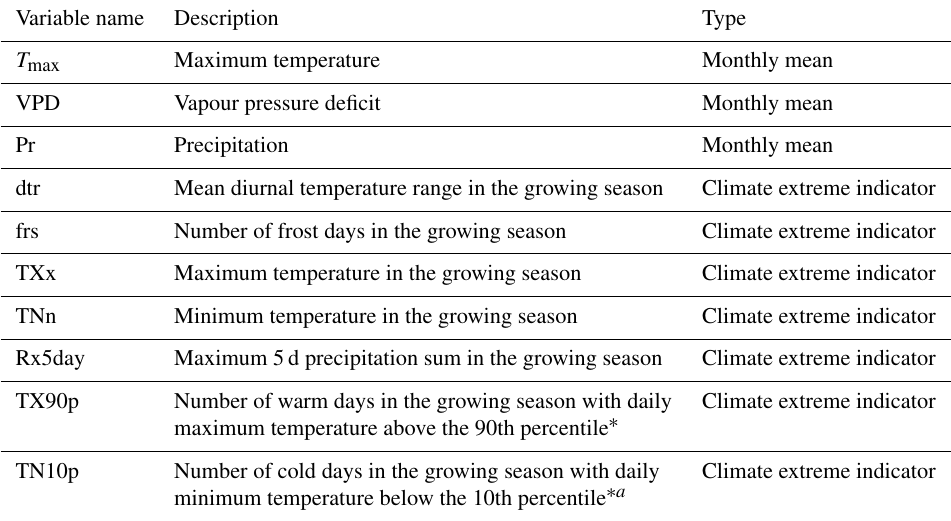
Figure 1. (a) Mean annual yield over the 1600 years (tha − 1 ). (b) Relative difference between the 5th percentile and the mean annual yield. Grid points discarded for our study are crossed out (specified in Sect. 2.2). Table 1. Meteorological drivers used in the